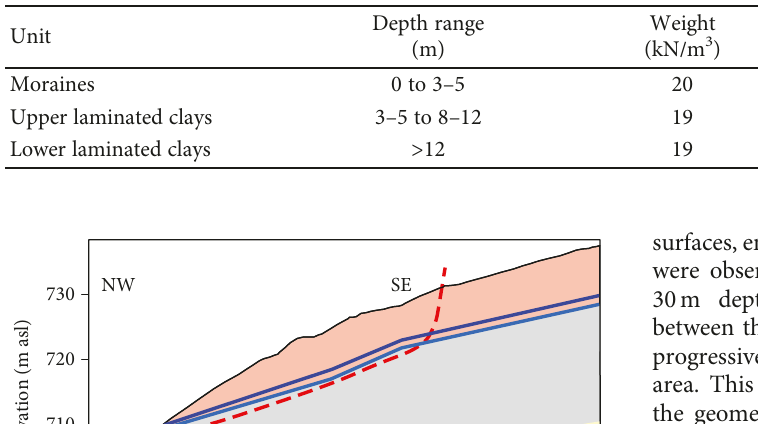
Table 2: Geotechnical parameters used for stability computations